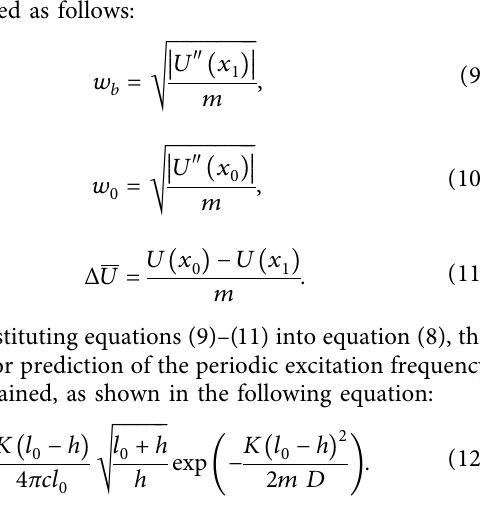
Figure 6: The power spectrum of the random signal.